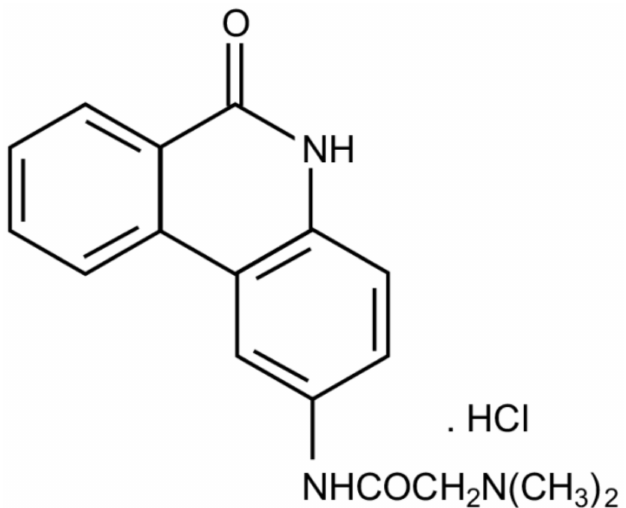
Figure1. ThechemicalstructureofPJ34, N -(6-Oxo-5,6-dihydrophenanthridin-2-yl)-( N , N -dimethylamino)acet amide